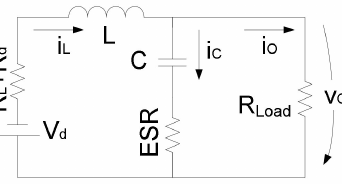
Figure 3. Buck converter circuit during the non-conduction